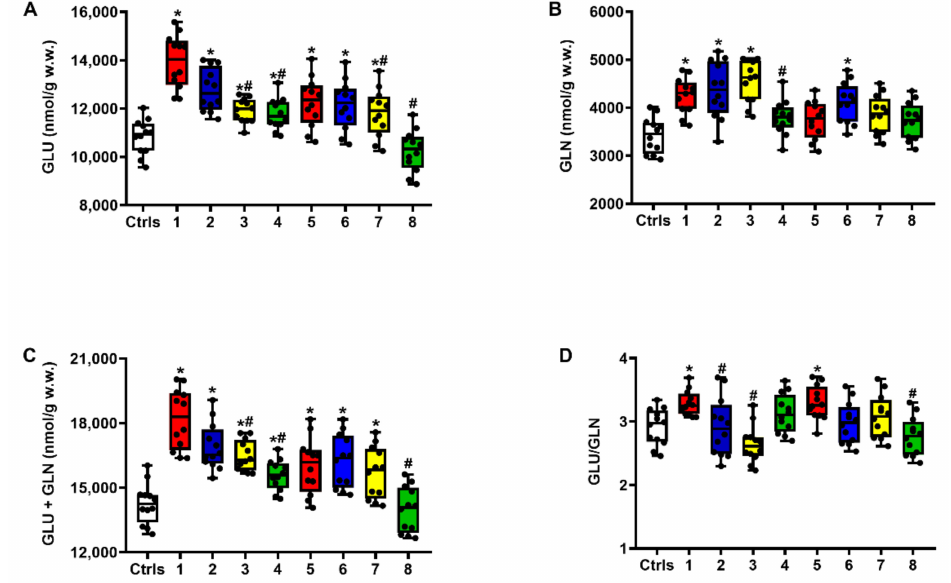
Figure 1. The box plots reporting all data points ( • ), minimum, maximum, median, 25 and 75 percentiles of Glu ( A ), Gln ( B ) and Glu + Gln ( C ), as well as the values of Glu/Gln ratio ( D ), in brain extracts of sTBI rats without and with the s.c. administration of increasing ILB ® doses (1, 5 and 15 mg/kg b.w.), measured at 2 and 7 days post-impact. Ctrls = control sham-operated rats; 1 = sTBI only, sacrificed at 2 days post-injury; 2 = sTBI + 1 mg/kg b.w. ILB ® , sacrificed at 2 days post-injury; 3 = sTBI + 5 mg/kg b.w. ILB ® , sacrificed at 2 days post-injury; 4 = sTBI + 15 mg/kg b.w. ILB ® , sacrificed at 2 days post-injury; 5 = sTBI only, sacrificed at 7 days post-injury; 6 = sTBI + 1 mg/kg b.w. ILB ® , sacrificed at 7 days post-injury; 7 = sTBI + 5 mg/kg b.w. ILB ® , sacrificed at 7 days post-injury; 8 = sTBI + 15 mg/kg b.w. ILB ® , sacrificed at 7 days post-injury. * Significantly different from controls, q < 0.05. # Significantly different from corresponding time of untreated sTBI rats, q <